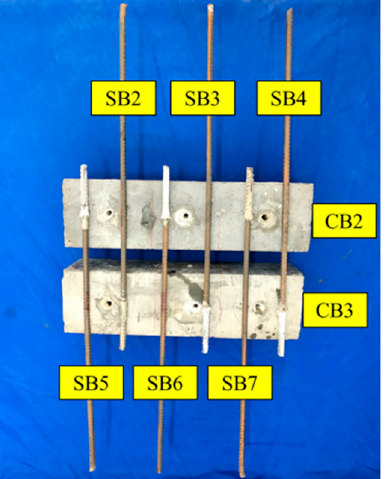
Figure 13. The specimen after the pull-out test. Table 2. The maximum tension value of the pull-out test.